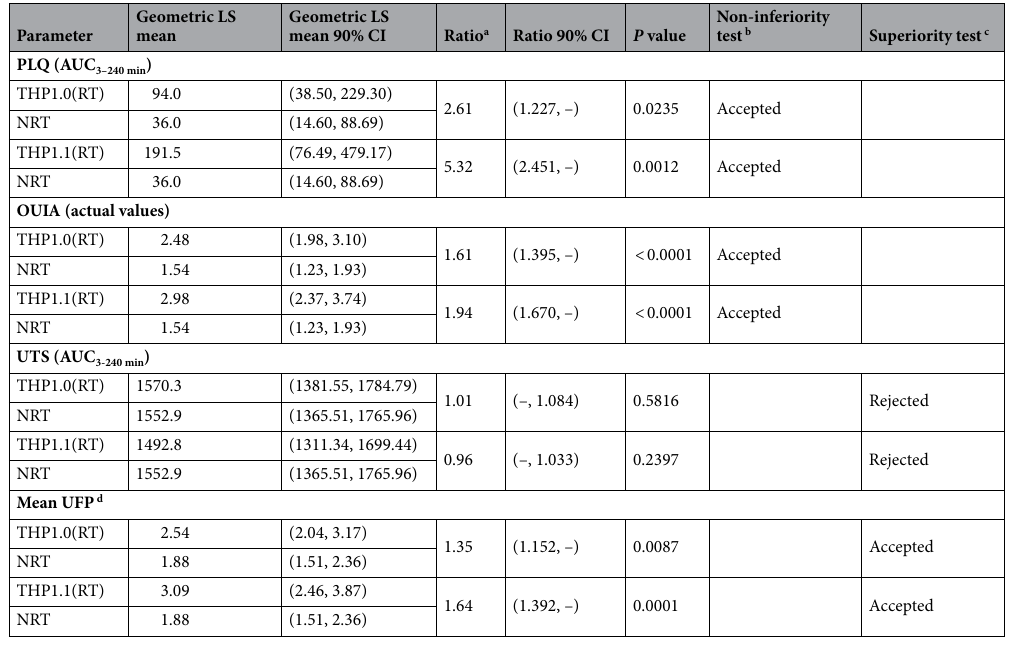
Table 5. Comparison of primary efficacy variables between each THP and the NRT. Parameters were log transformed and 1 was added to avoid a logarithm of 0. The transformed parameters were analysed by an ANOVA model, including treatment, sequence and period as fixed effects, and subject-within-sequence as a random effect. CI confidence interval, LS least squares, THP tobacco heating product, NRT nicotine replacement therapy. a Calculated by transforming the difference between the natural log LS means back to the original scale. b PLQ and OIUA were confirmed as non-inferior if the lower bound of the one-sided 90% Cl of the ratio was more than 0.80. c UTS was confirmed as superior if the upper bound of the one-sided 90% Cl of the ratio was less than 1.0. UFP was confirmed as superior if the lower bound of the one-sided 90% Cl of the ratio was more than 1.0. d Mean of the scores recorded at 15 and 120